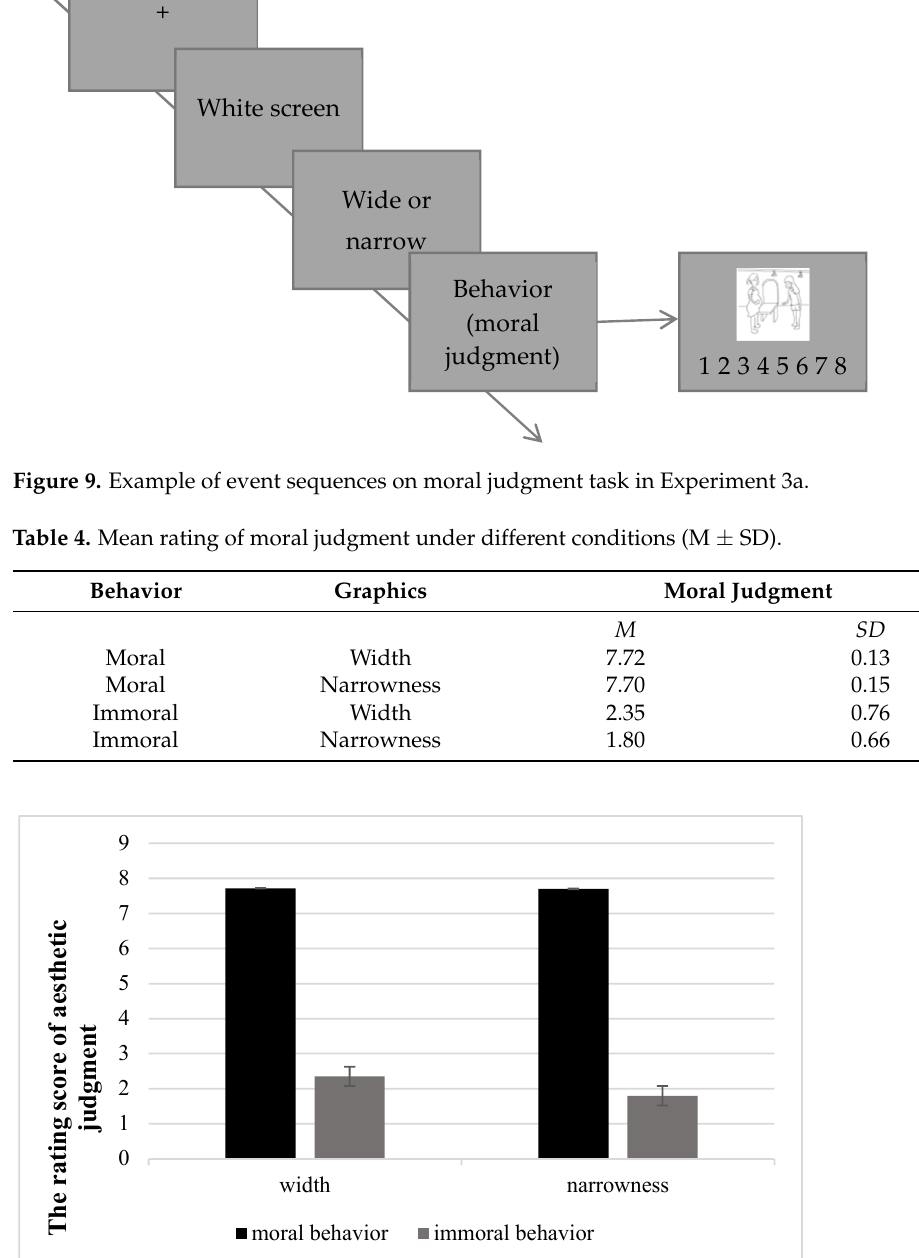
Figure 10. The interaction effect between graphics and behavior.